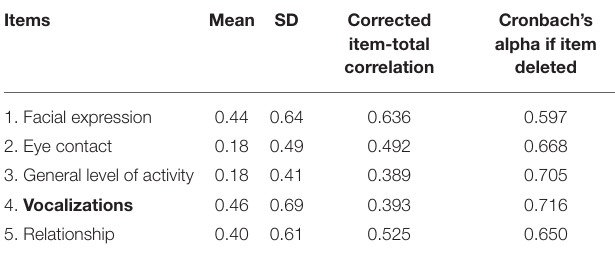
TABLE 4 | Internal consistency of the m-ADBB scale in the first evaluation.